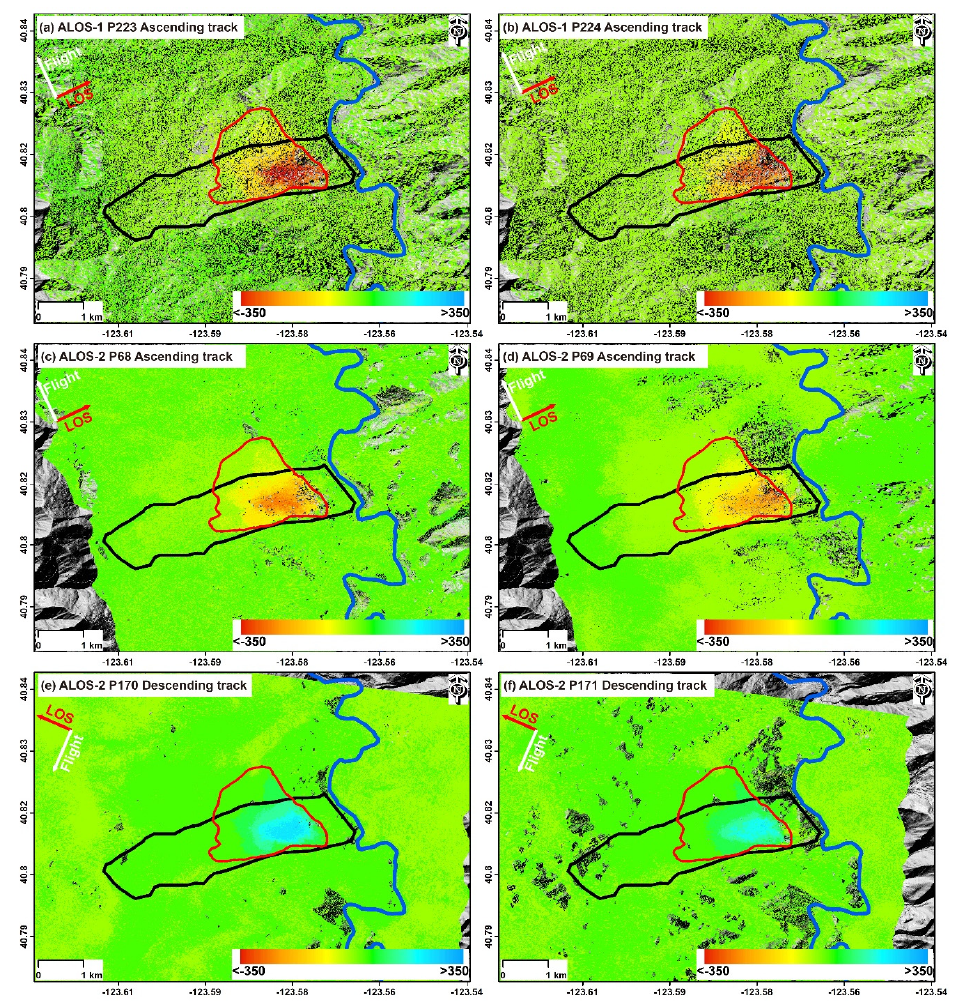
Figure 4. Average LOS deformation rate maps of the Three Bears landslide calculated with L-band SAR datasets (unit: mm/yr). The figures in the first and second row show the results derived from ascending datasets: ( a ) P223 of ALOS PALSAR-1 (data period: 2007–2011), ( b ) P224 of ALOS PALSAR-1 (data period: 2007–2011), ( c ) P68 of ALOS PALSAR-2 (data period: 2015–2017), and ( d ) P69 of ALOS PALSAR-2 (data period: 2014–2017). The figures in the third row show the results derived from descending datasets: ( e ) P170 of ALOS PALSAR-2 (data period: 2015–2017) and ( f ) P171 of ALOS PALSAR-2 (data period: